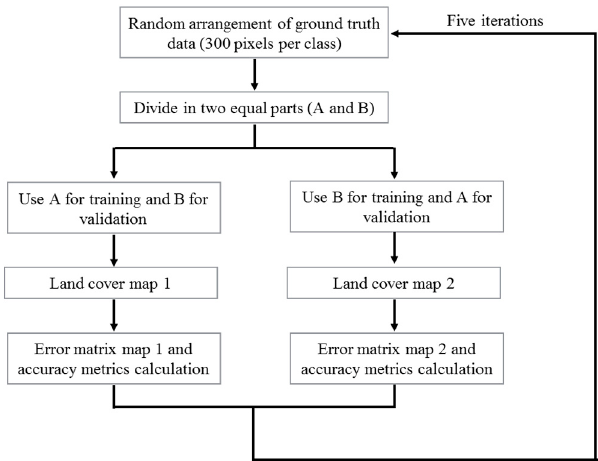
Figure 2. Procedure used to select the pixels for training and validation in the supervised classification based on the cross-validation technique.